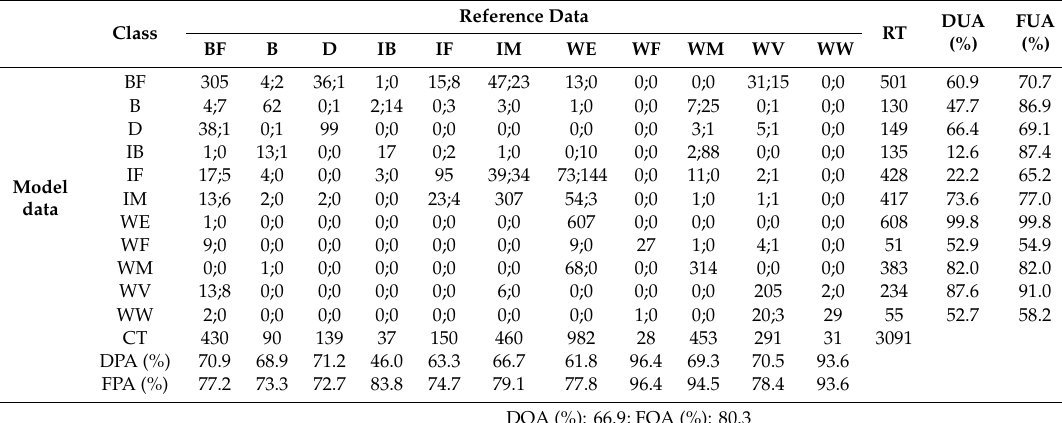
Table A7. Error matrix with deterministic and fuzzy accuracies for the initial contemporary model results (i.e., without post-processing and a four-pixel minimum mapping unit) for Dauphin Island, Alabama, USA. For the o ff -diagonal cells, the first value indicates deterministic count and the second value indicates the fuzzy count. BF: Barrier flat; B: Beach; CT: Column total; D: Dune; DPA: